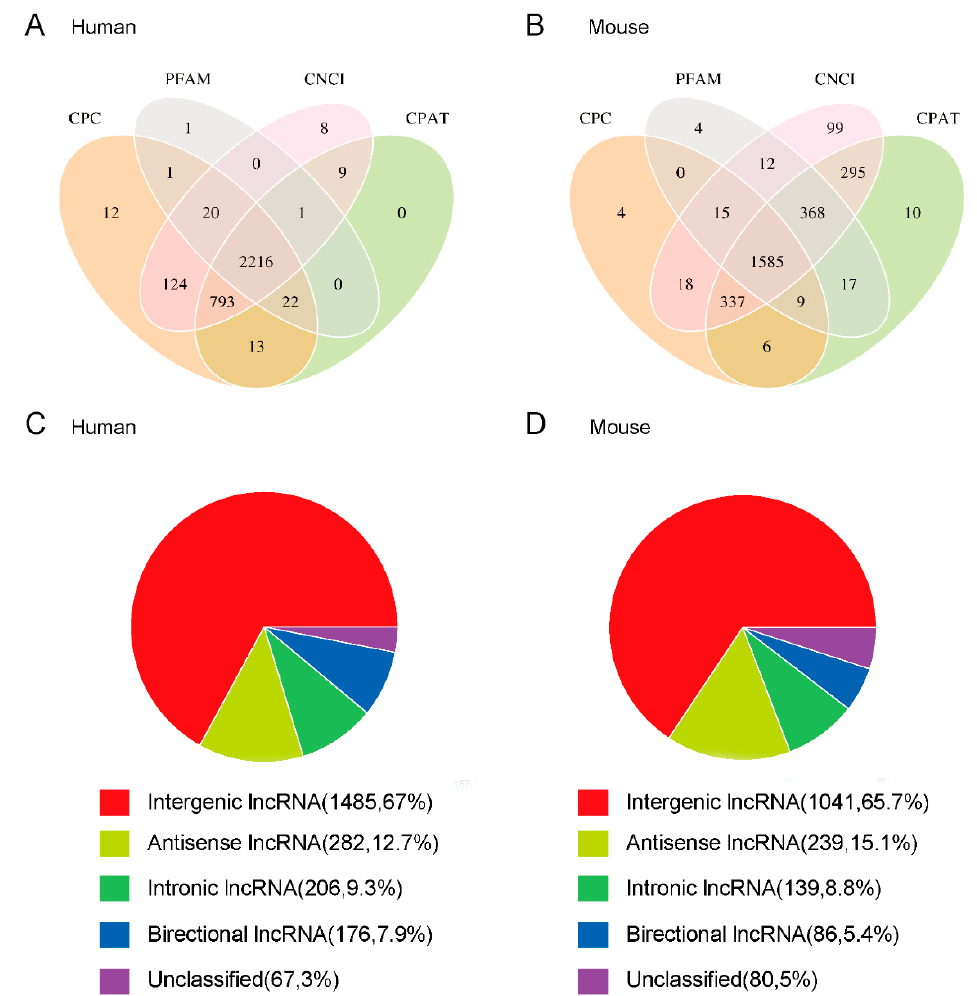
Figure 3. Identification and classification of newly predicted lncRNAs. Venn diagram of the protein-coding ability prediction results in RD cells ( A ) and mice skeletal muscle ( B ). lncRNA classification annotation statistical graph for RD cells ( C ) and skeletal muscle of mice ( D ).